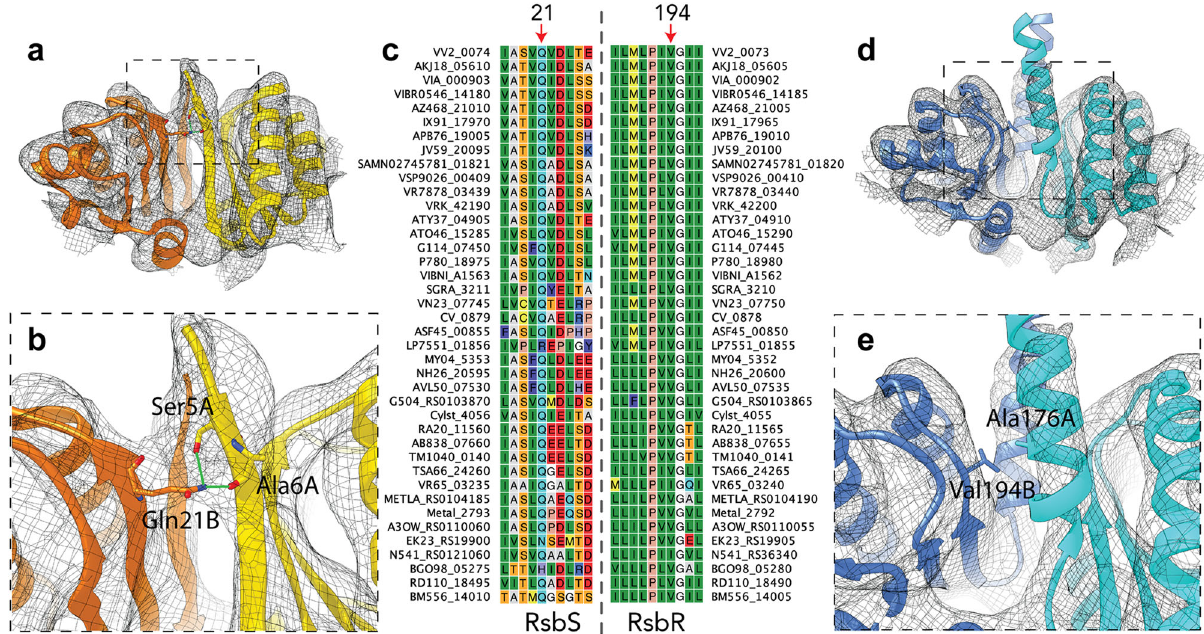
Fig. 6 Interactions within the Vv RsbS and Vv RsbR STAS-domain interfaces and conservation of the involved residues within Gram-negative Bacteria. a , b Vv RsbS and ( d , e ) Vv RsbR are shown in different shades of yellow and blue, respectively, fi tted into the D2 cryo-EM density map (shown as black mesh). Protomers within the dimers of ( a ) Vv RsbS form intradimeric contacts via the β 1-sheets (b) that likely result in increased stability of the dimer in comparison to Vv RsbR (for the residues contributing to the contacts, carbon atoms are colored blue or yellow/orange respectively, oxygen atoms in red, and nitrogen atoms in dark blue). c Gln21 in Vv RsbS is conserved in RsbS homologs from other Gram-negative bacteria. d Unlike Vv RsbS, Vv RsbR forms α - helices at the intradimeric interface that continue into the N-terminal turret-forming domain without obvious inter-monomeric contacts. e Val194 in Vv RsbR is conserved in other RsbR homologs ( c ) and does not feature a clustering of polar sidechains (hydrophobic residues are shown on a green background and polar charged, charged + , charged − , aromatic, are shown on light blue, dark blue, red and violet background,